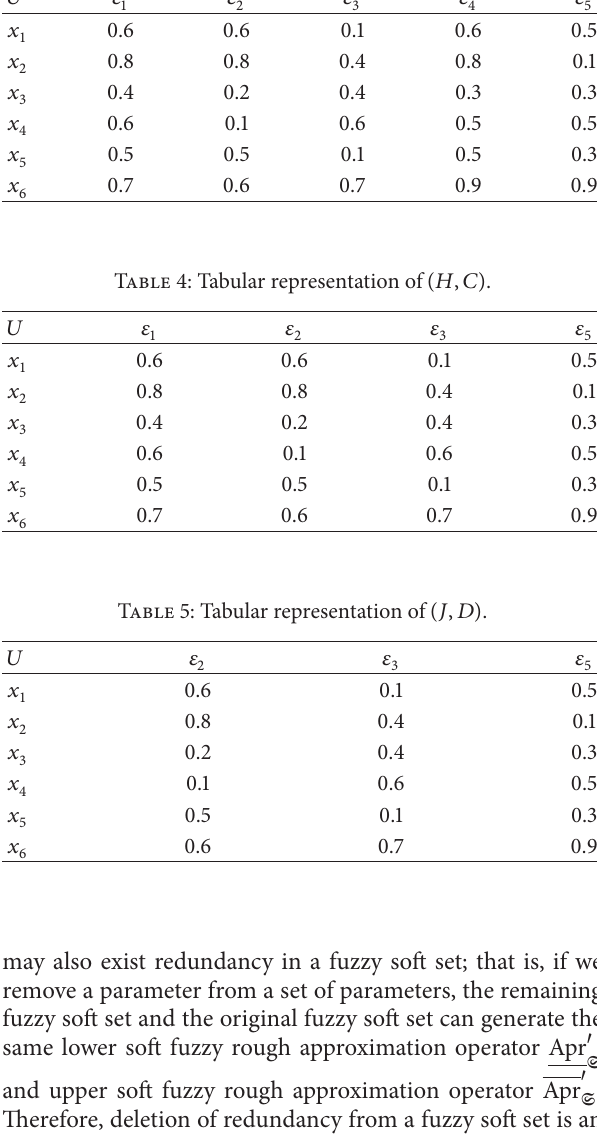
fuzzy soft sets generate the same lower soft fuzzy rough approximation operator Apr 󸀠 rough approximation operator Apr